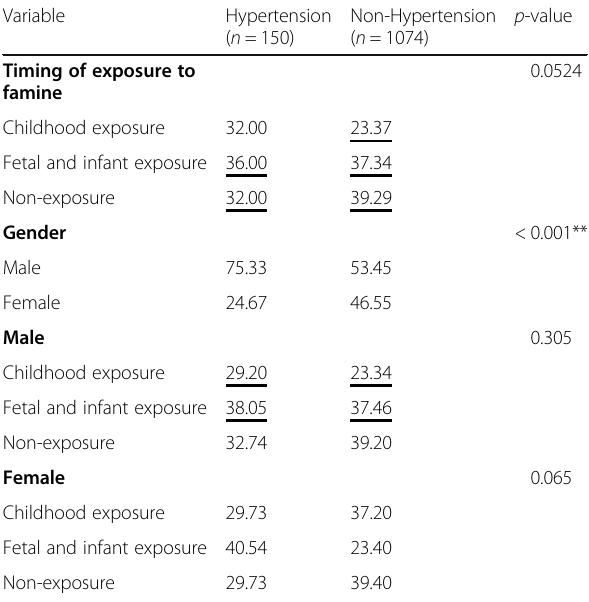
Table 1 Characteristics of the study participants, Chongqing,